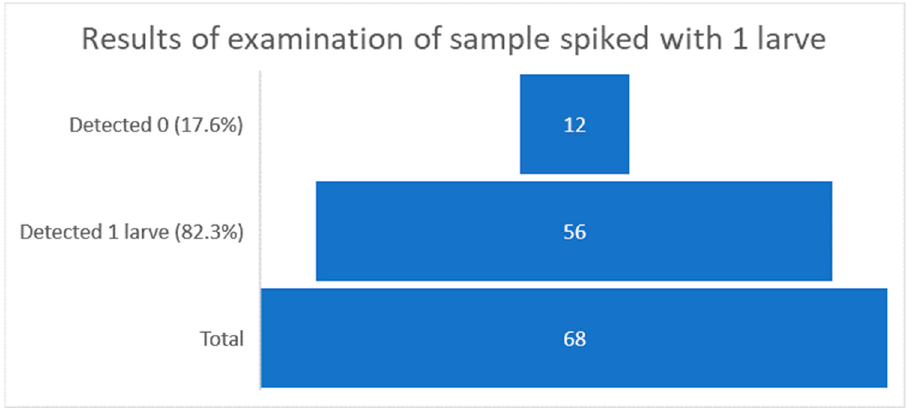
Figure 1. Graphical interpretation of the distribution of sample results examined at the method detection limit (number of laboratories in bricks).